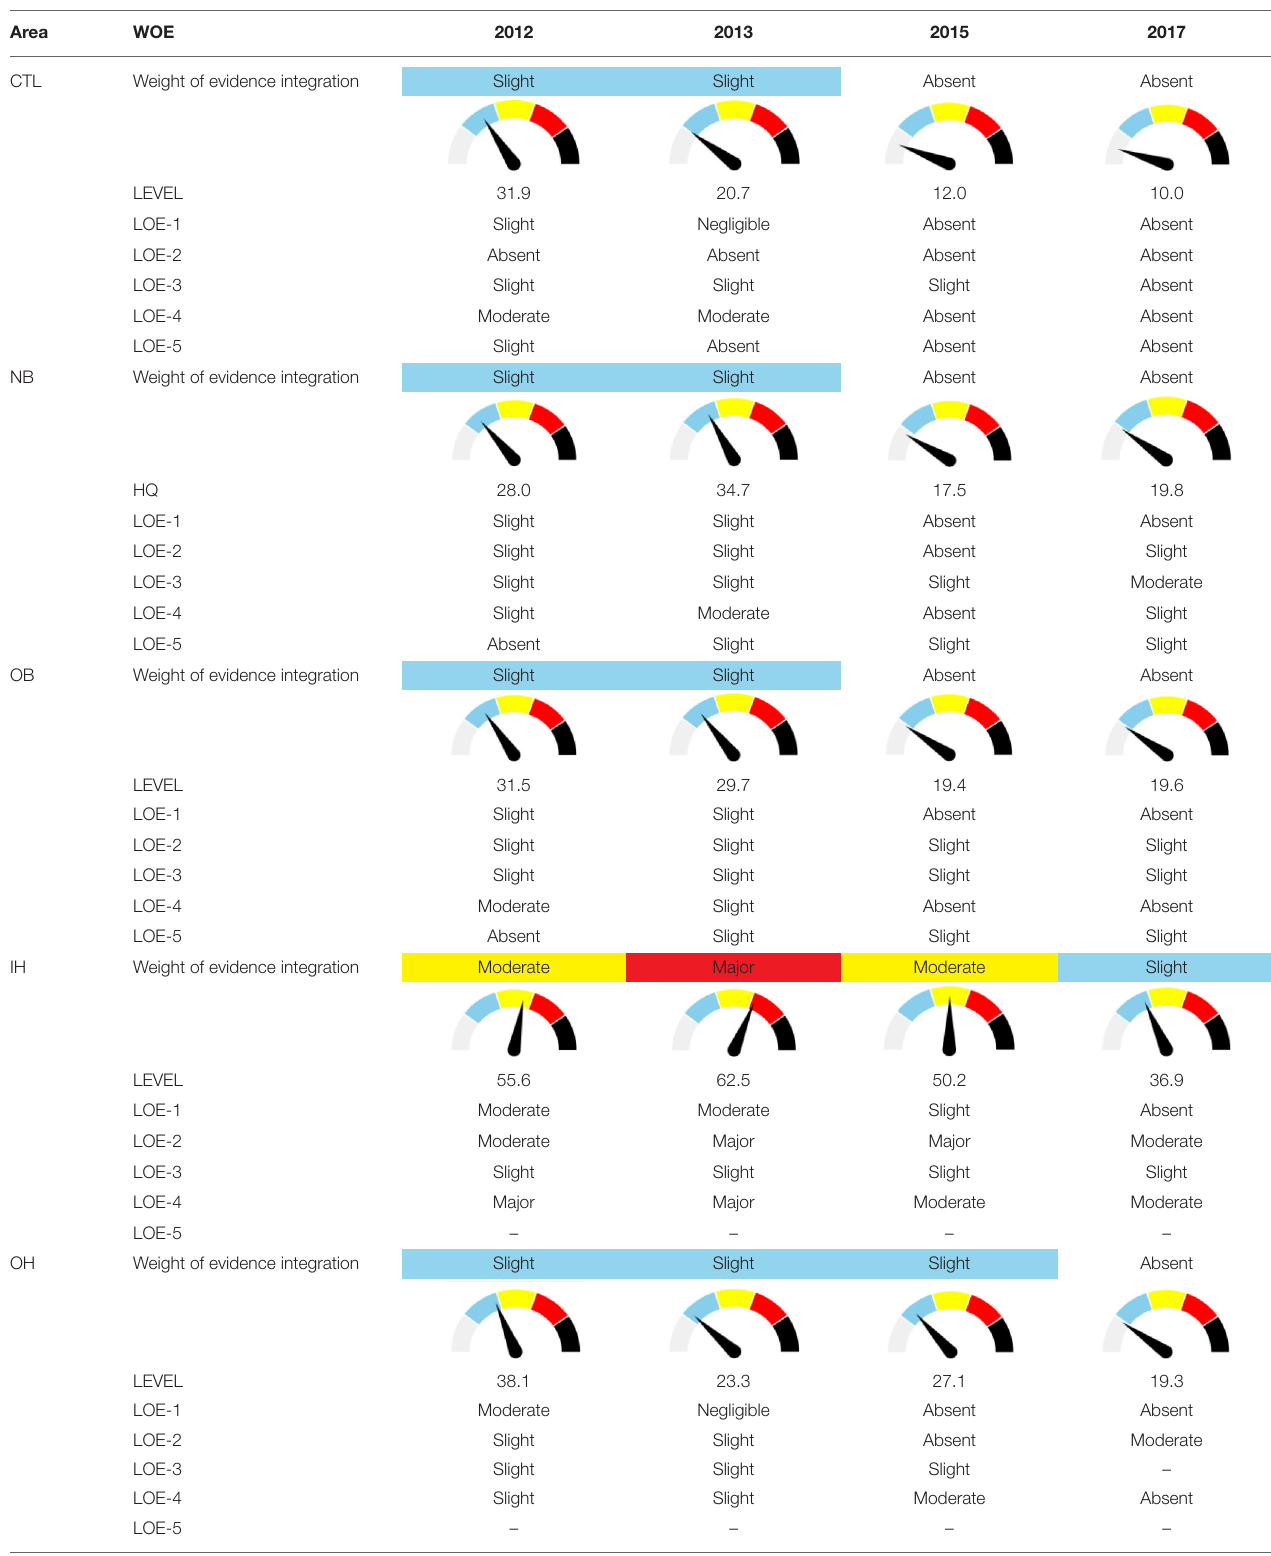
TABLE 6 | Resume of the sediqualsoft